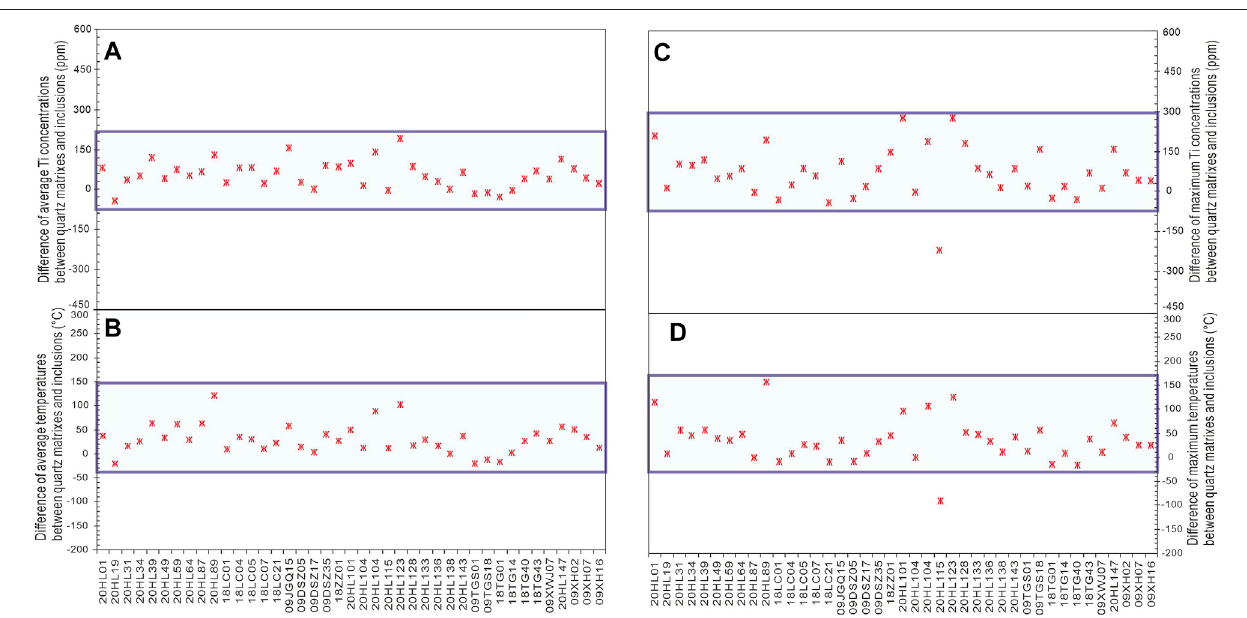
FIGURE 5 | Comparison of quartz titanium concentrations and the calculated temperatures by TitaniQ thermometer between matrix-type quartz and quartz inclusions in garnet. (A) Difference of the average quartz titanium concentrations between matrix-type quartz and quartz inclusions; (B) Difference of the average calculated temperatures between matrix-type quartz and quartz inclusions; (C) Difference between the maximum titanium concentrations between matrix-type quartz and quartz inclusions; (D) Difference between maximum calculated temperatures between matrix-type quartz and quartz inclusions; The Y axes are that Ti concentrations of quartz or calculated temperatures of matrix-type quartz minus those of quartz inclusions in garnet in each sample.